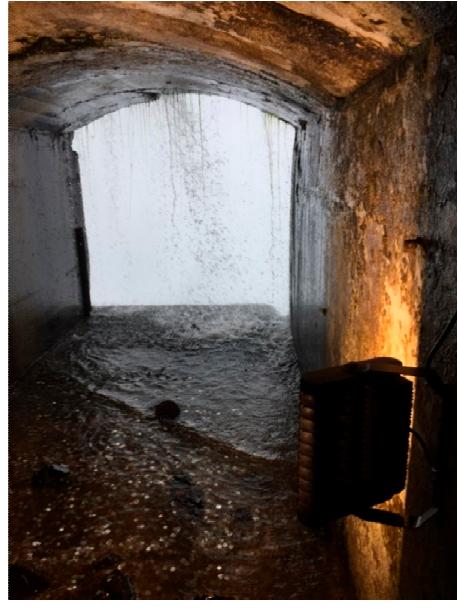
Figure 8. “Behind Niagara Falls” (photo by Dalla Malé Fofana).